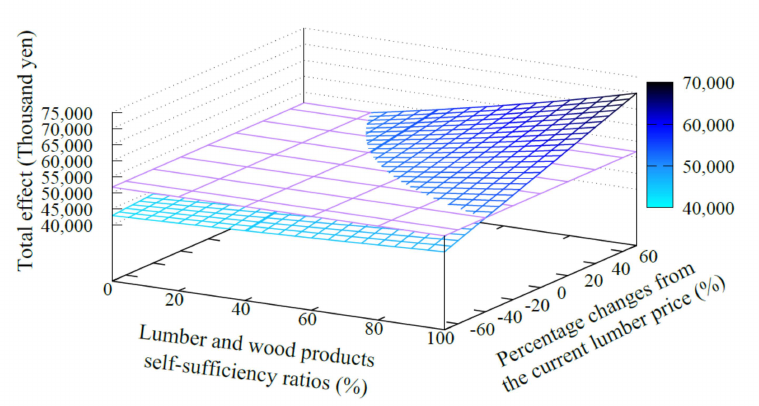
Figure 5. Impact of changes in the prefecture’s self-su ffi ciency ratios for the lumber and wood products sectors and the lumber price on the total e ff ect (blue), and the total e ff ect of the concrete check dam construction